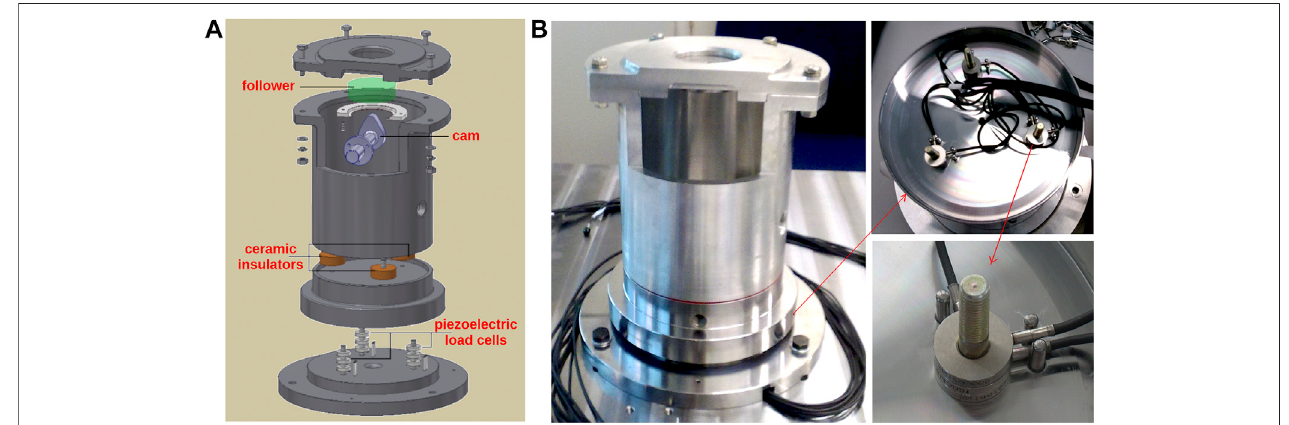
FIGURE 2 | Measurement unit. (A) Schematic drawing. (B) Photographs with details of the annular load cells.